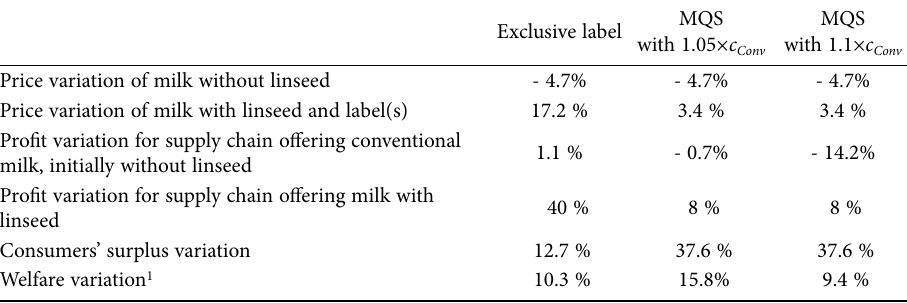
Table 2. Relative variations (%) in profit and surplus coming from the exclusive label or the